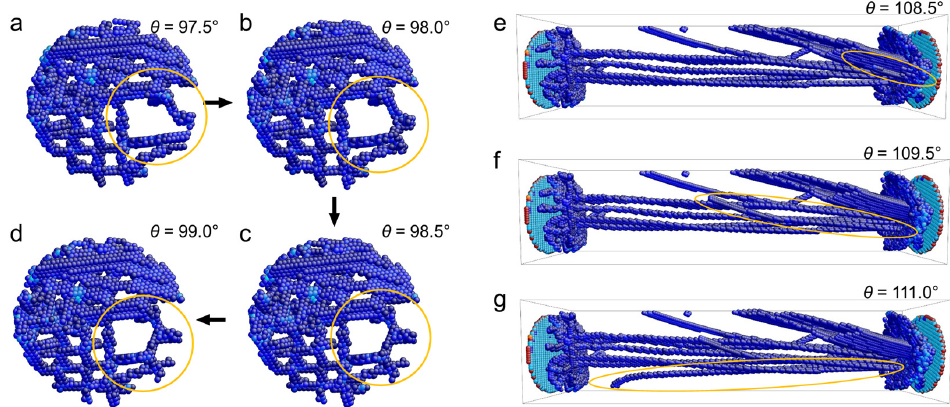
Figure 5. Typical atomic configurations during the evolution of ( a – d ) short dislocations near the loading end and ( e – g ) long dislocations along the wire. Typical dislocation segments are encircles in orange.